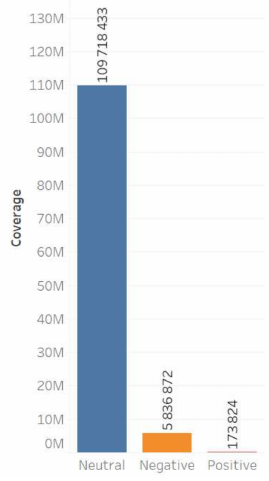
Figure 3. Sentiment of the regional actors’